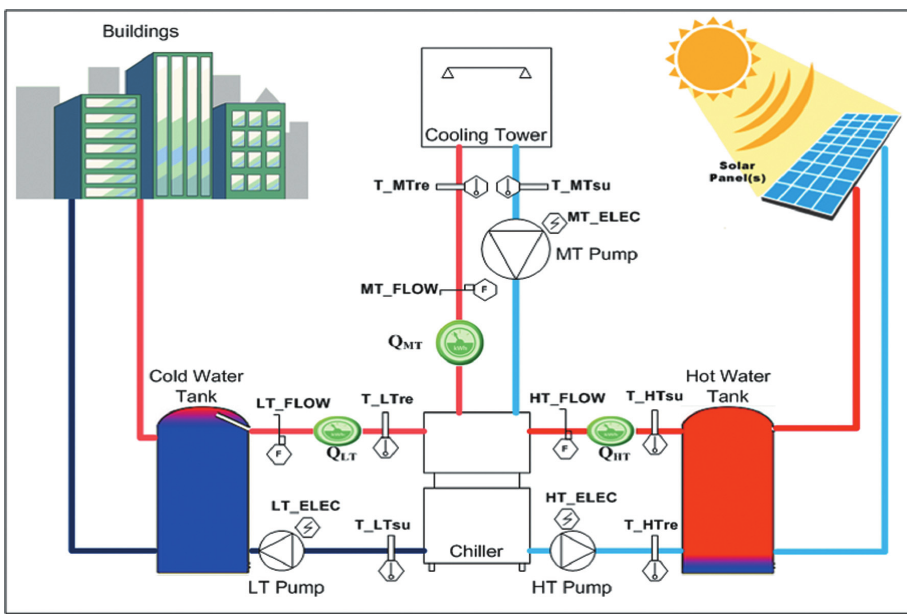
Figure 5. Adsorption chiller system configuration. Table 1 . Parameters Description. Table 2. Parameters